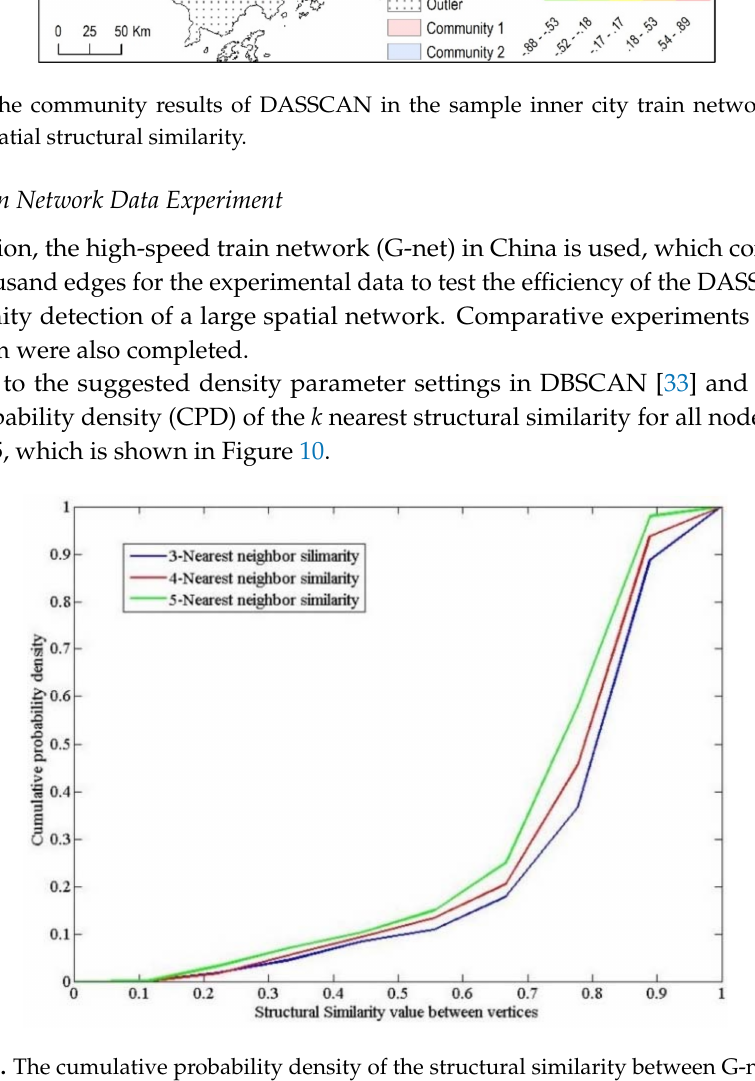
Figure 10. The cumulative probability density of the structural similarity between G-net